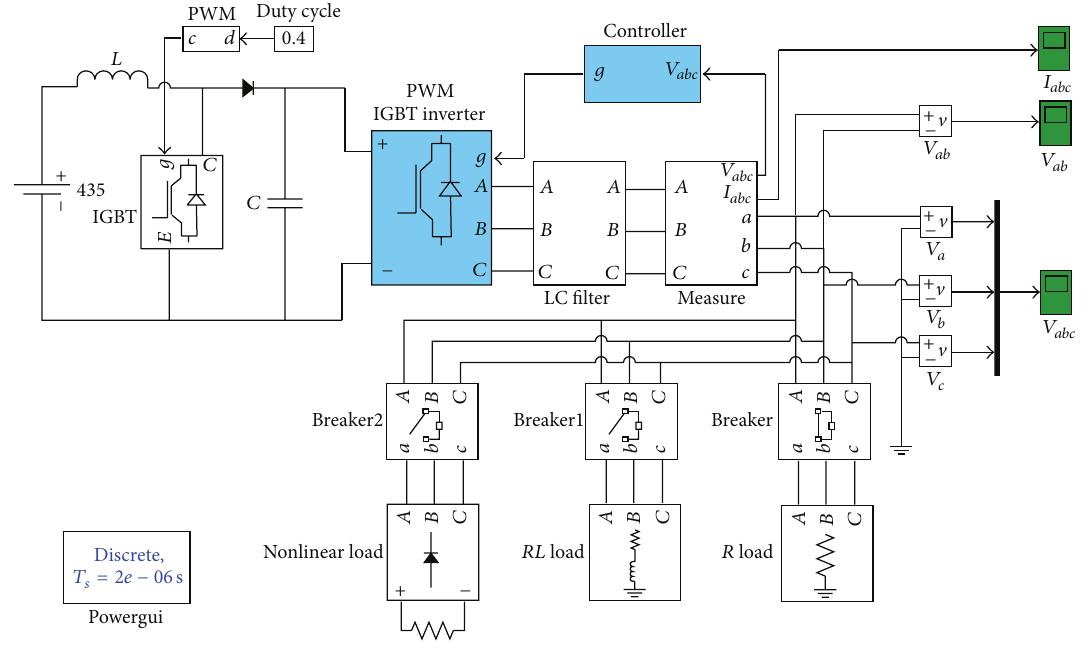
Figure 8: Simulation model for the three-phase inverter.